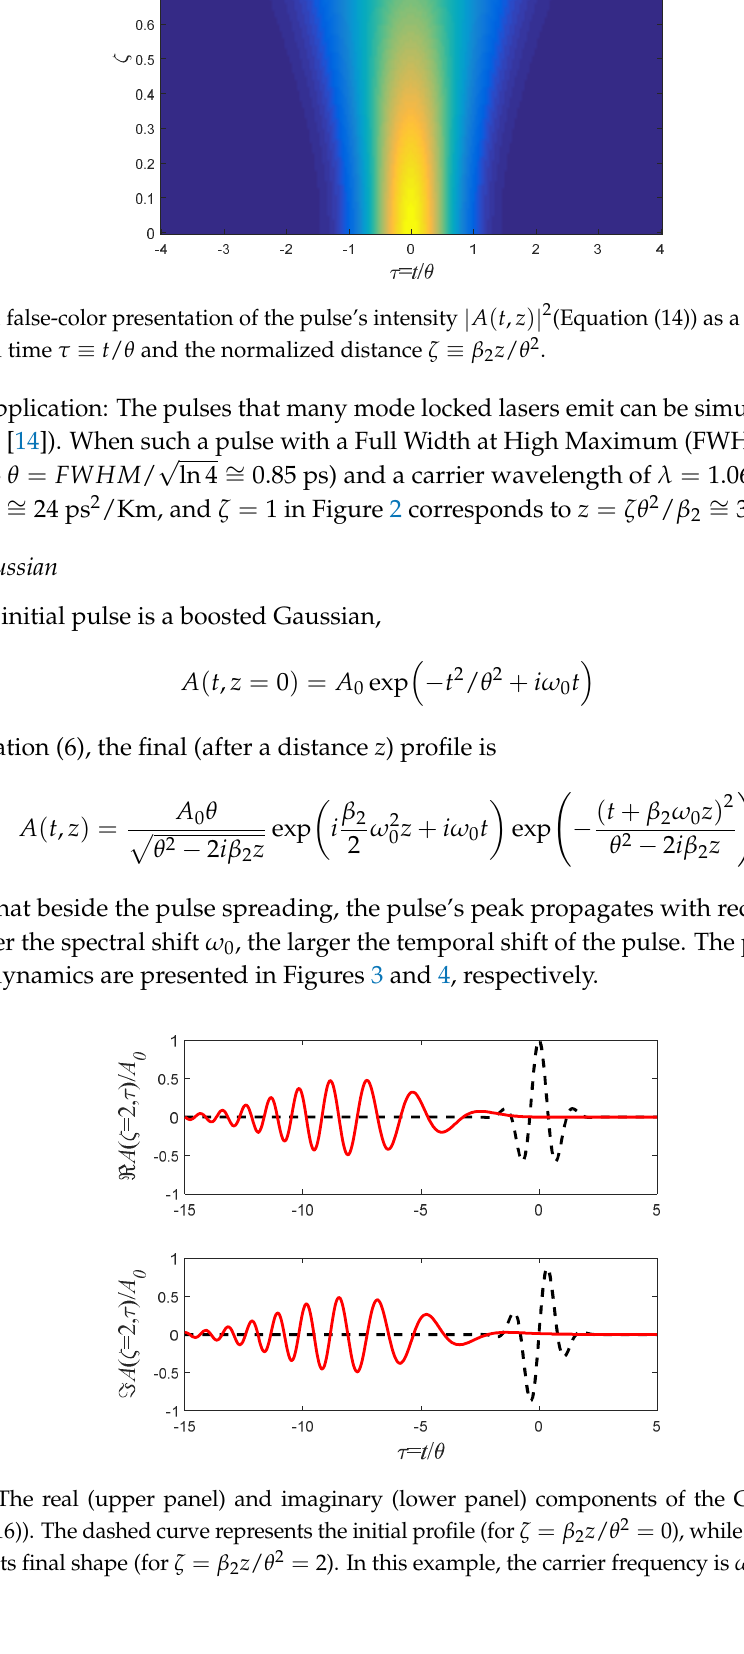
Figure 1. The real (upper panel) and imaginary (lower panel) components of the pulse (Equation (14)). The dashed curve represents the initial profile (for 0/ 2 represents the signal after a distance, which corresponds to 2/ 2 units of  , which corresponds to the pulse’s temporal width.